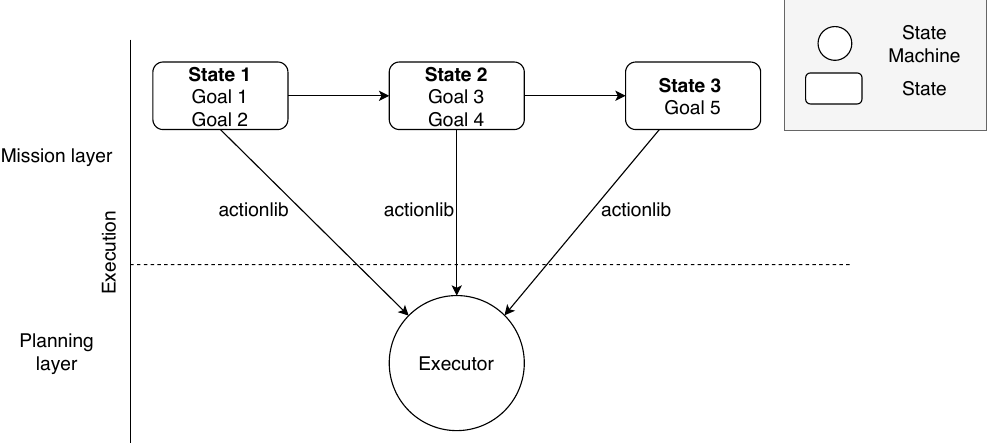
Figure 3. Communication diagram of Mission layer, designed as a Finite-State Machine and the Executor from the Planning